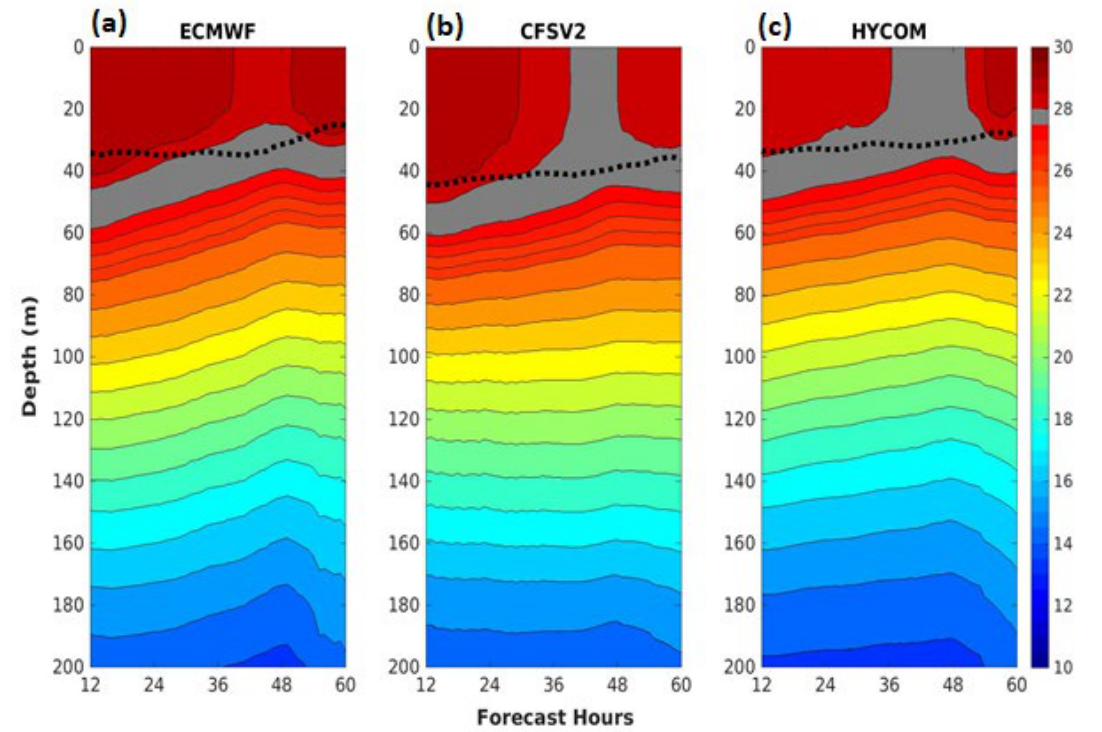
Figure 10. Vertical profile for temperature (°C, shading) overlaid with the MLD (black dashed line) (calculated over the VFB) as obtained from the experiments. The region with temperatures between 27.8 and 28.4 °C is marked in gray.